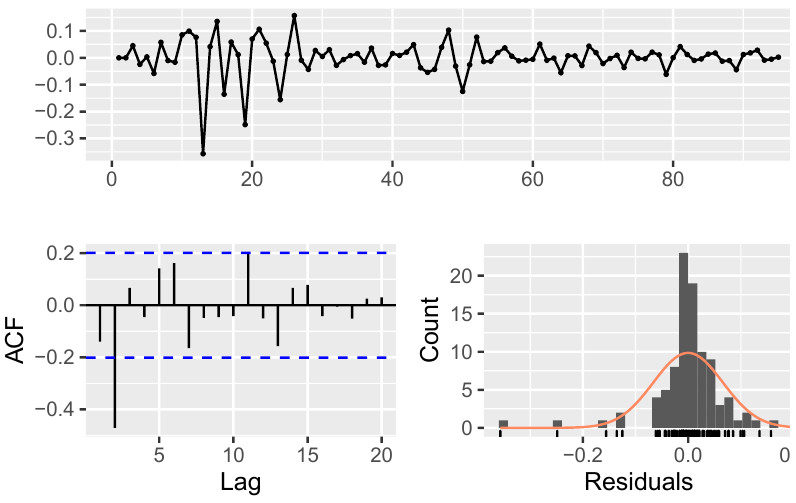
Figure A3. Residuals from ARIMA(1,2,1) for Stock 3.